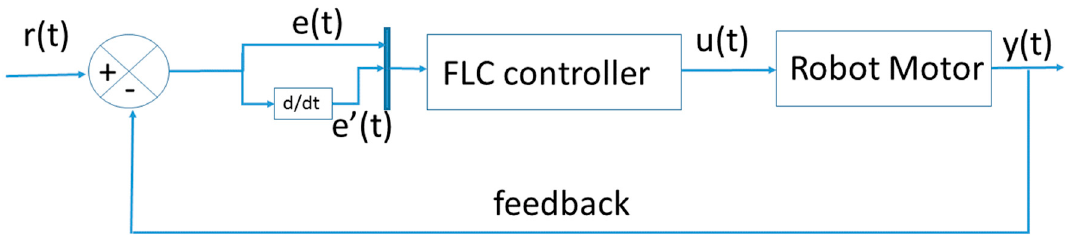
Figure 7. Structure of the fuzzy logic controller.